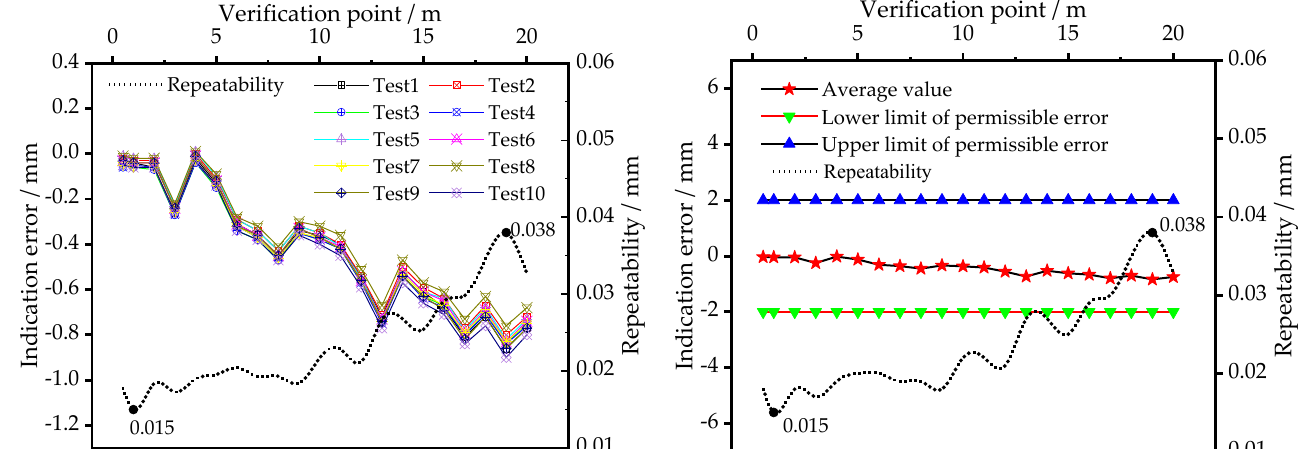
Figure 13. Indication error test of 5m arc ruler.